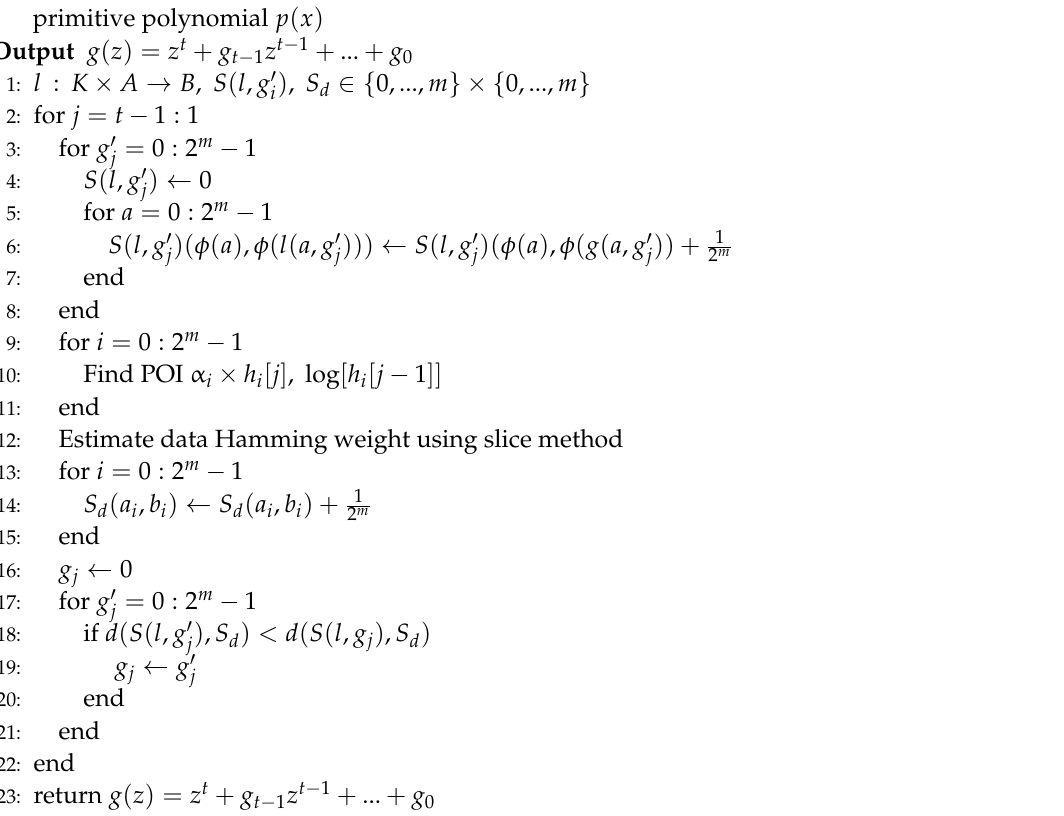
Algorithm 10 Analysis for g ( z )